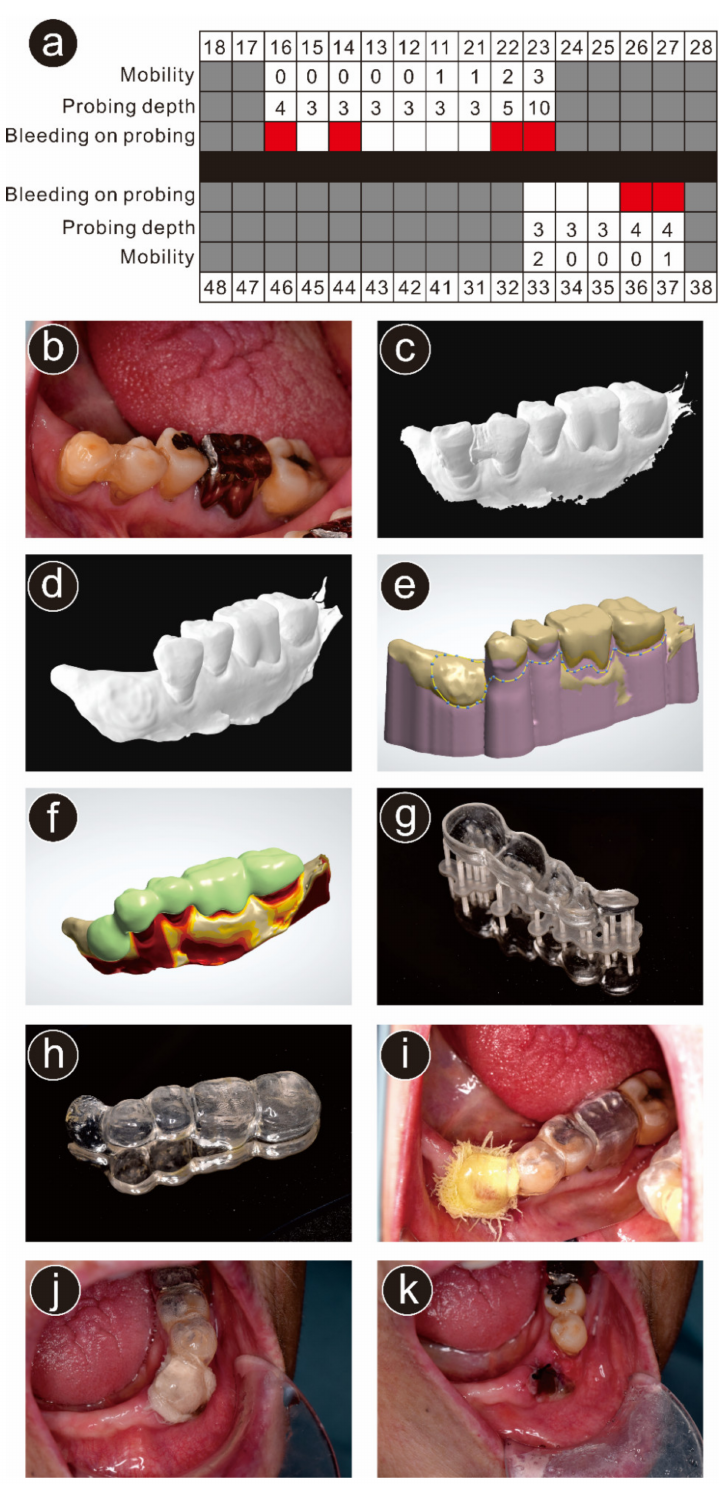
Figure 2. Case presentation of the participant in this report. ( a ) Periodontal chart at the first visit. Gray-colored blocks indicate missing teeth and red-colored blocks indicate bleeding on probing; ( b ) intraoral view before extraction; ( c ) STL data obtained from the intraoral scanner (TRIOS 3); ( d ) stereolithography data after deletion of the left mandibular canine; ( e ) designing the surgical splint using three-dimensional (3D) computer-aided design software; ( f ) designed surgical splint; ( g ) the surgical splint printed using a 3D printer; ( h ) trimmed and finished surgical splint; ( i ) delivered surgical splint; ( j ) intraoral view 2 days after the extraction (before removal of the surgical splint); ( k ) intraoral view of the extraction wound 2 days after the